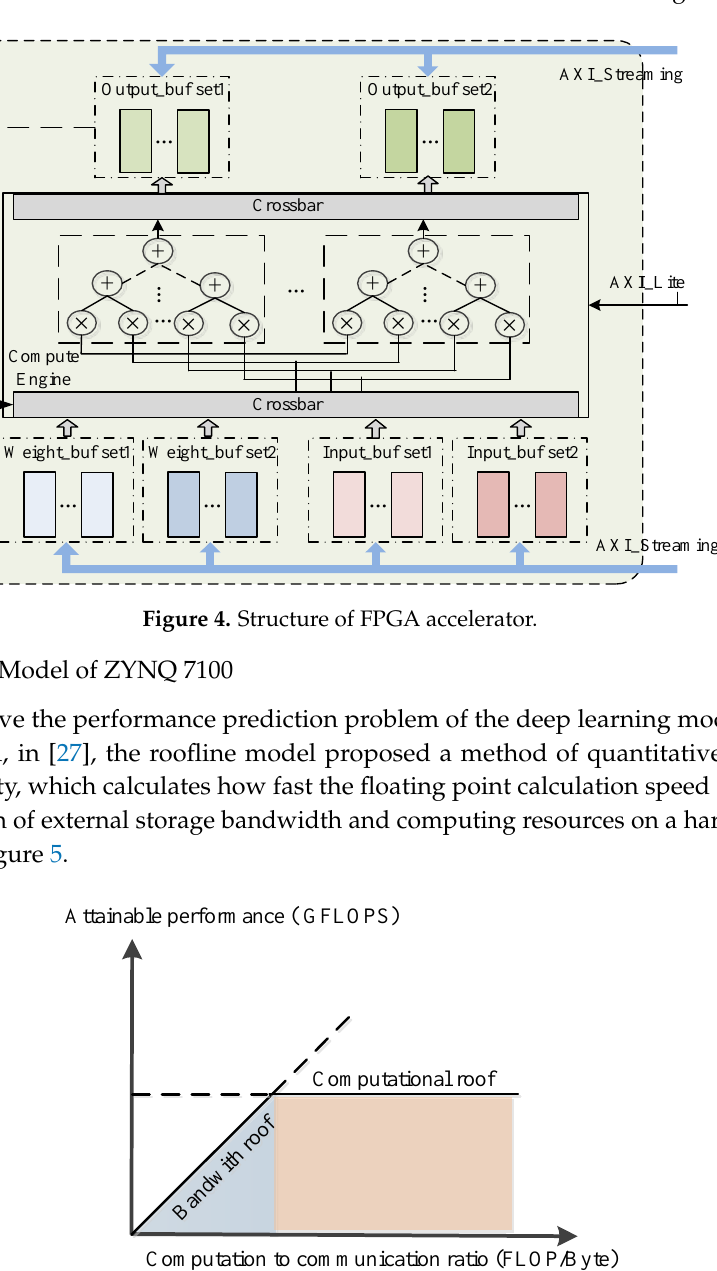
Figure 5. Roofline Figure 5. Roofline model. Figure 5. Roofline model.